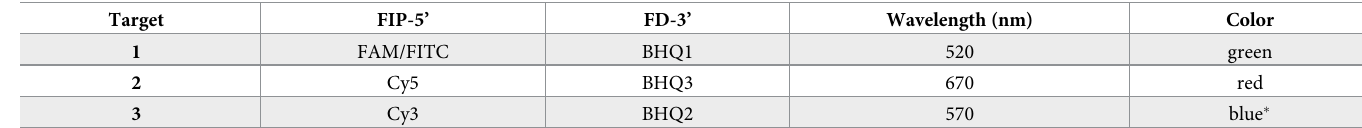
Table 1. The fluorophores and detection channels. Target